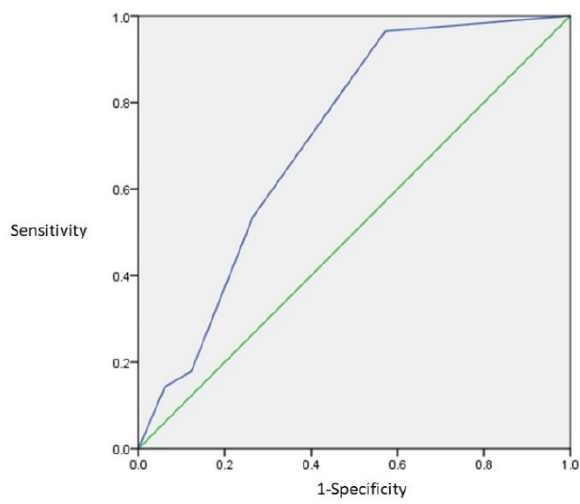
Figure 9. The ROC curve of the vertical hyoid bone position. The AUC was 0.715. Table 6. Results of Youden Index (Sensitivity − (1 − Specificity)) and Table 4. Prevalence of the horizontal position of hyoid bone.